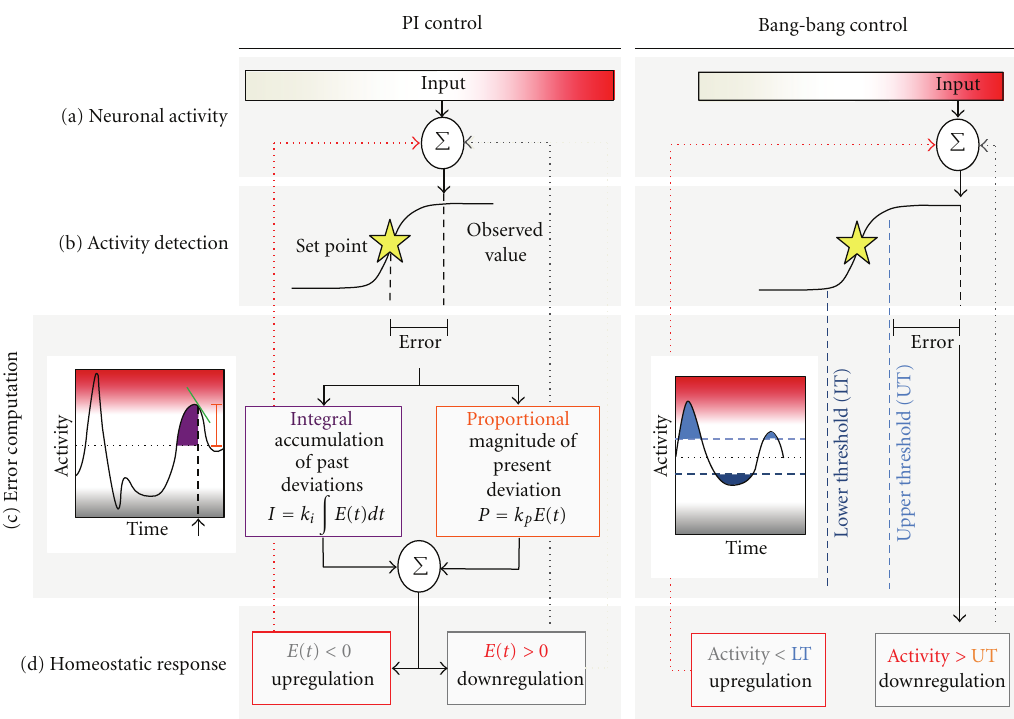
Figure 1: Closed-loop control in homeostatic regulation. In closed-loop control systems, observed activity values (a) are compared to a desired set point (yellow star) (b) and deviations are registered as errors (c). The homeostatic response program is calculated and initiated in response to the error signal (d). Many control strategies are possible, including proportional-integral (PI) control (left) and bang- bang control (right). PI control : PI controllers compute a compensatory response as a function of the properties of the error, namely, the proportional (orange, magnitude at t = 0 indicated with arrow) and integral (purple, cumulative error over time) components of the deviation. A variation of this regulation, the proportional-integral-derivative (PID) controller, also incorporates a derivative component that detects the rate of change of the deviation (green bar in activity trace, D = k D dE ( t ) / dt ). The initiated response is therefore tailored to the immediate degree of deviation from the set point (proportional), the cumulative magnitude of the deviation (integral), and the rate of change of the deviation (derivative). Bang-bang control : Bang-bang control consists of set compensatory responses which are initiated once a threshold is crossed (blue lines) and halted once the activity value returns to the acceptable range of